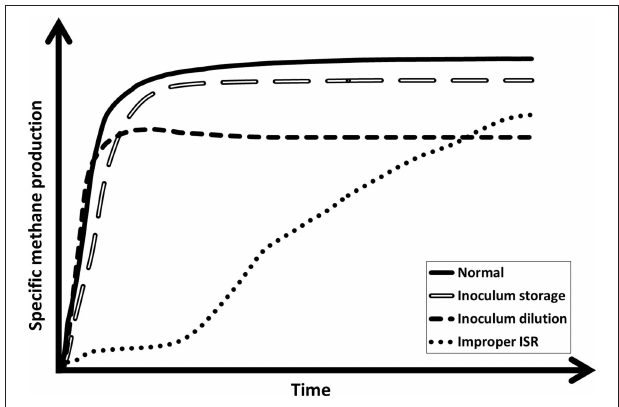
FIGURE 5 | A normal specific methane production curve and the impact of three typical faults in the experimental design or